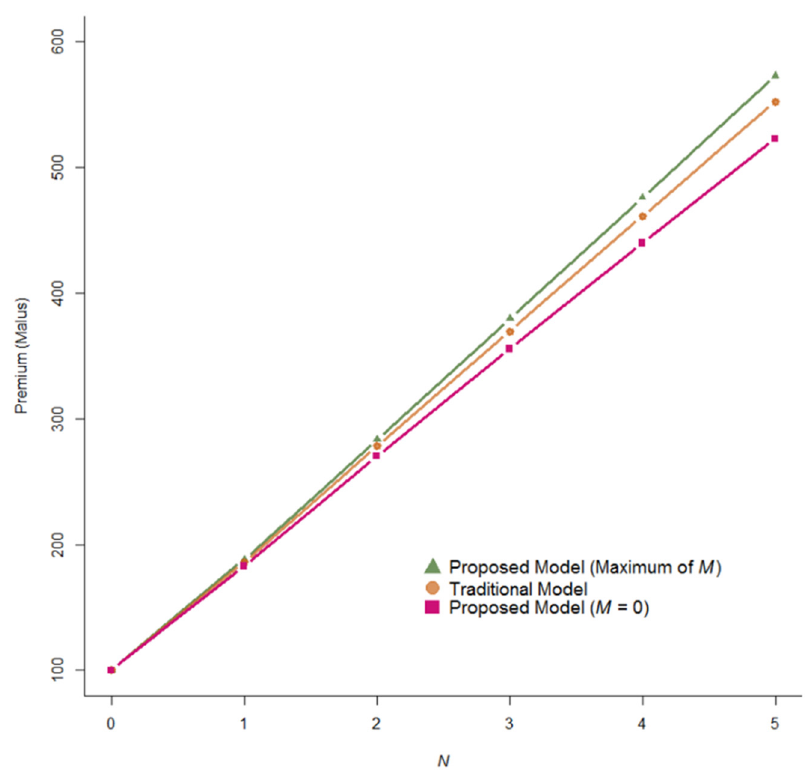
Figure 5. Comparison of the premiums between the traditional Poisson-Lindley model and the pro- proposed Poisson binomial-Lindley beta model in the first posed Poisson binomial-Lindley beta model in the first year.